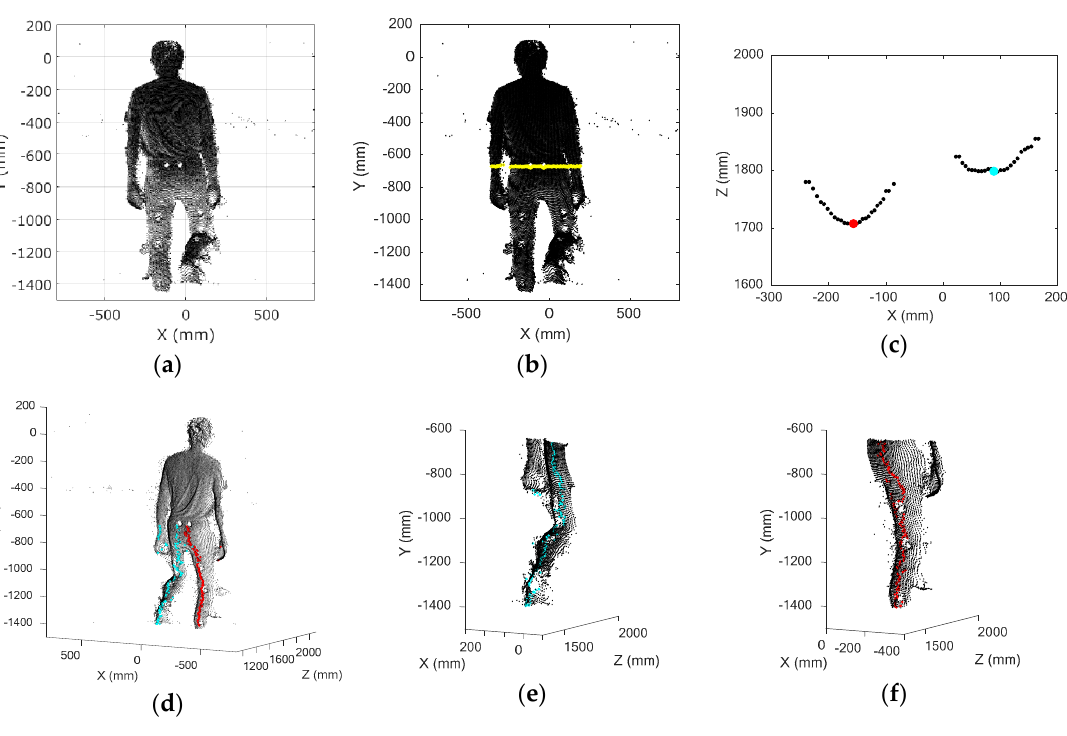
Figure 7. Body range definition and leg data extraction: ( a ) body extraction by using a histogram of Y values; ( b ) body plots and the boundary (yellow line) separating the body into upper and lower parts; ( c ) example of X – Z section at an arbitrary Y position; ( d ) representative positions of left and right legs; ( e ) separated left leg and its representative positions; ( f ) separated right leg and its representative positions.